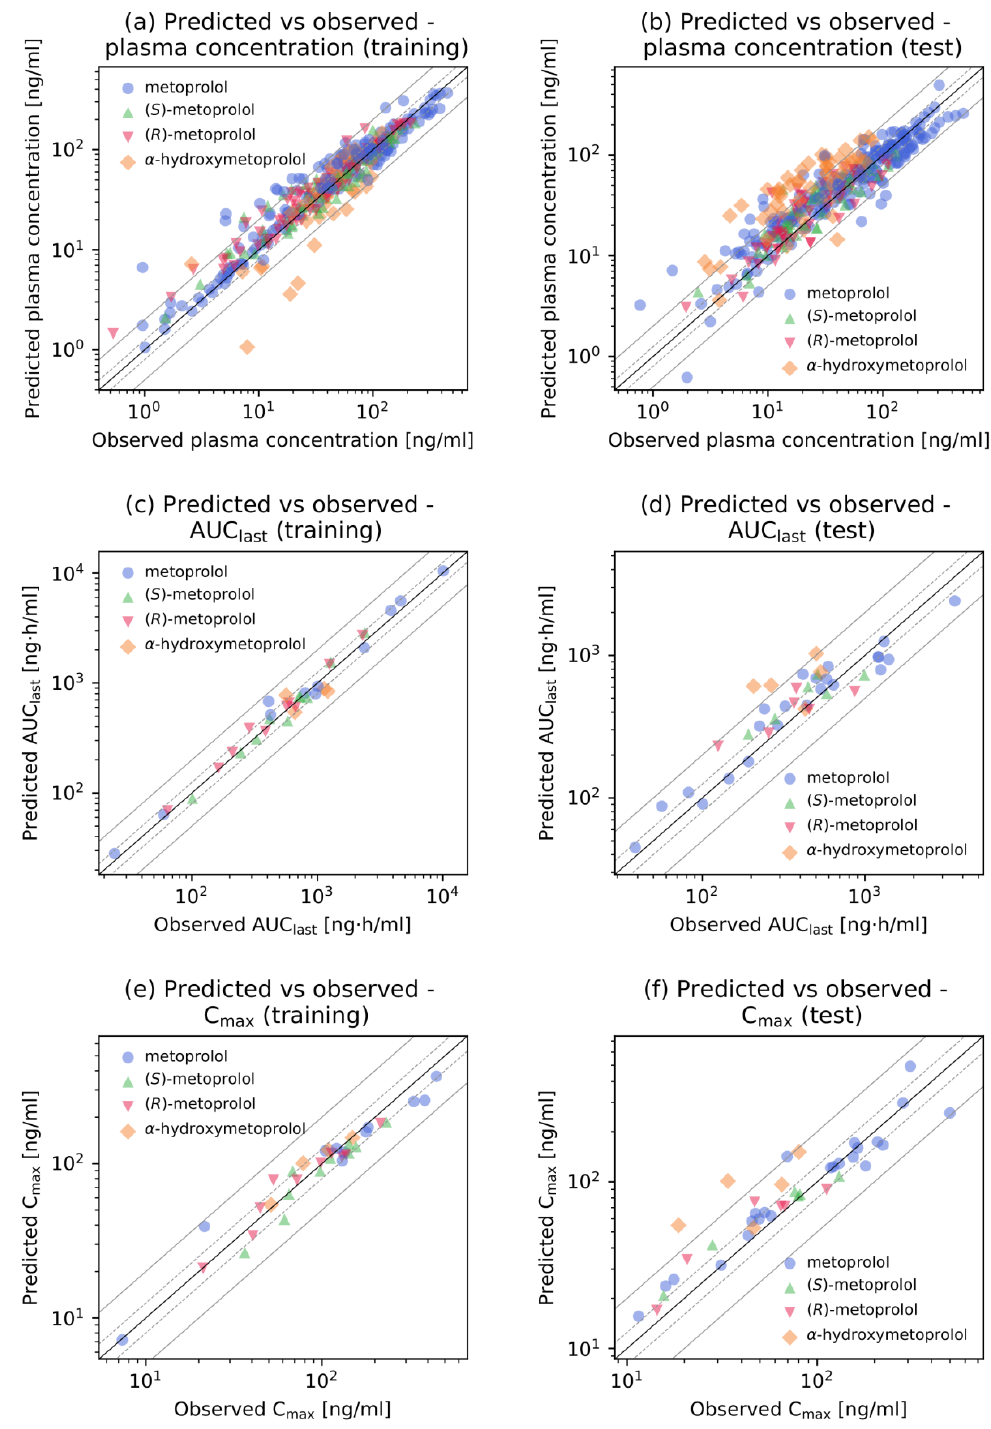
Figure 3. Goodness-of-fit plots of the final metoprolol model. Predicted versus observed ( a , b ) plasma Figure 3 concentrations, ( c , d ) AUC last values and ( e , f ) C max values for the training (left column) and test (right column) datasets. The solid black line indicates the line of identity, solid grey lines show two-fold deviation, dashed grey lines indicate 1.25-fold deviation. Detailed information on all clinical studies is listed in Supplementary Table S2.2.1. AUC last : area under the plasma concentration-time curve from the time of the first concentration measurement to the time of the last concentration measurement, C max : maximum plasma concentration, vs: